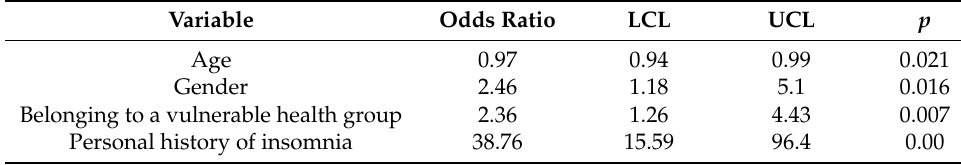
Table 2. Personal contributory factors to